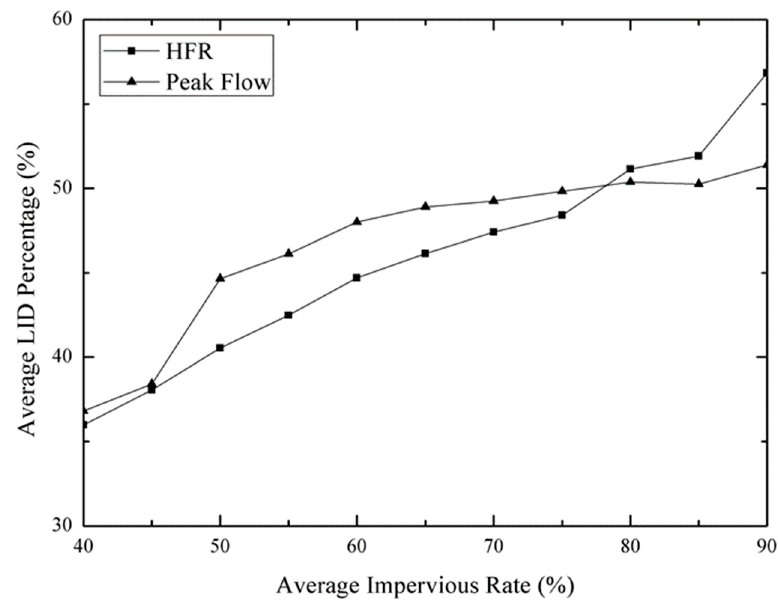
Figure 14. The relationship between the optimal allocation ratio and the average impervious rate for the flood peak and the